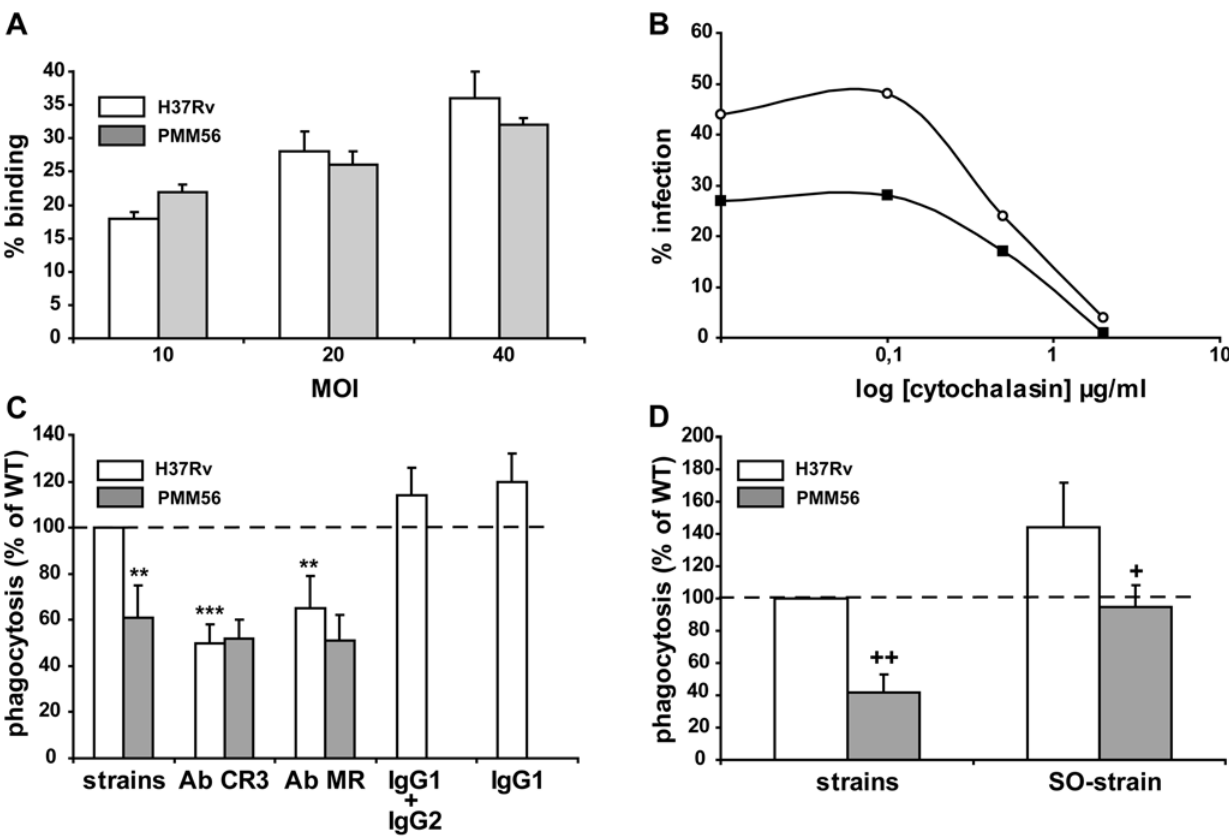
Figure 3. DIM participate in the control of the receptor-dependent phagocytosis of H37Rv. (A) MDMs were incubated for 30 minutes at 4 u C with the WT or the PMM56 mutant, at various MOI, and binding was determined by assessing immunofluorescence. Data are presented as the percentage of macrophages having bound at least one bacterium; one experiment that is representative of two independent experiments. (B) MDMs were incubated at 37 u C for 30 minutes with various concentrations of cytochalasin and were then infected with either H37Rv WT (white circle) or the PMM56 mutant (black square) at an MOI of 10. Data are presented as percentage phagocytosis; one experiment representative of two independent experiments. (C) MDMs were incubated at 37 u C for 30 minutes with irrelevant IgG1 or a cocktail of IgG1 and IgG2 or with mAbs directed against CR3 or MR. They were then washed and infected for 60 minutes with H37Rv WT or the PMM56 mutant at an MOI of 10. Data are presented as the percentage of phagocytosis compared to WT value (100% H37Rv). (D) MDMs were infected for 60 minutes with serum-opsonized (SO-strain) or non opsonized strains H37Rv WT or the PMM56 mutant at an MOI of 10. Data are presented as the percentage phagocytosis with respect to WT (H37Rv; 100%). The values presented are means 6 SEM of three independent experiments. The significance of difference between mAb-treated cell and untreated cells was evaluated: *, p , 0.05; **, p , 0.02. We also evaluated the significance of difference between mutants and the WT strain: + , p , 0.05; ++ , p ,